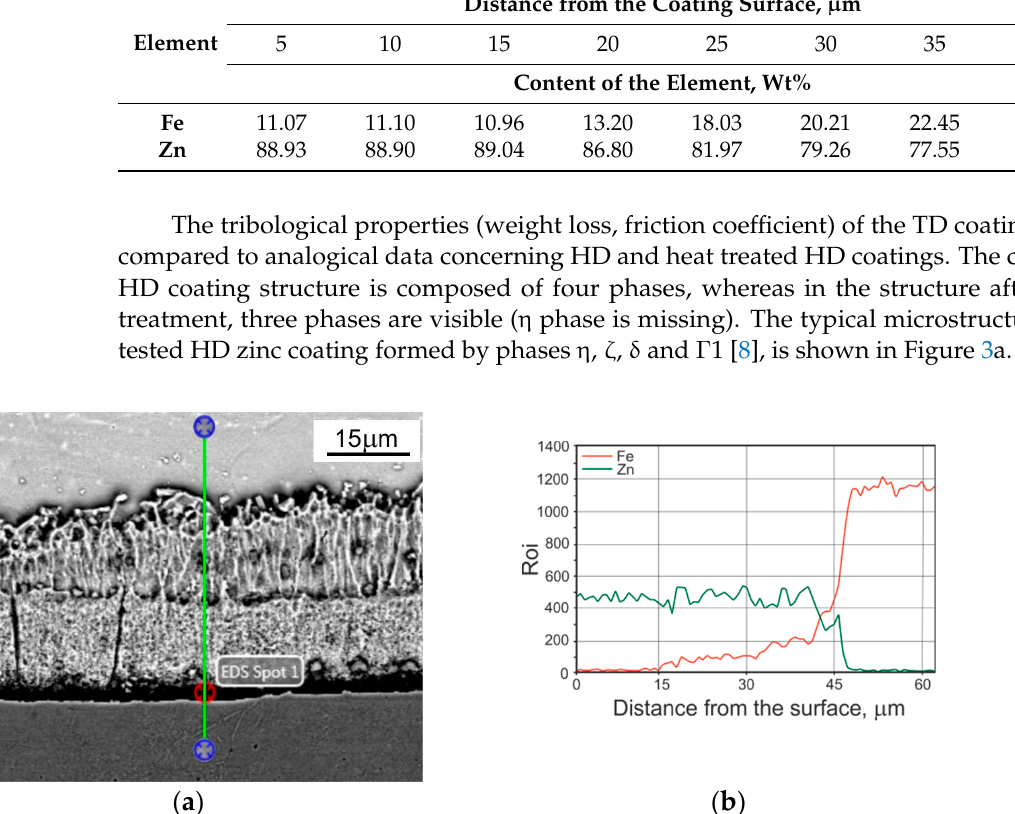
Figure 3. The microstructure observed at the cross section of the tested HD zinc coating deposited on disc-shaped samples: ( a ) SEM; ( b ) linear EDS analysis.